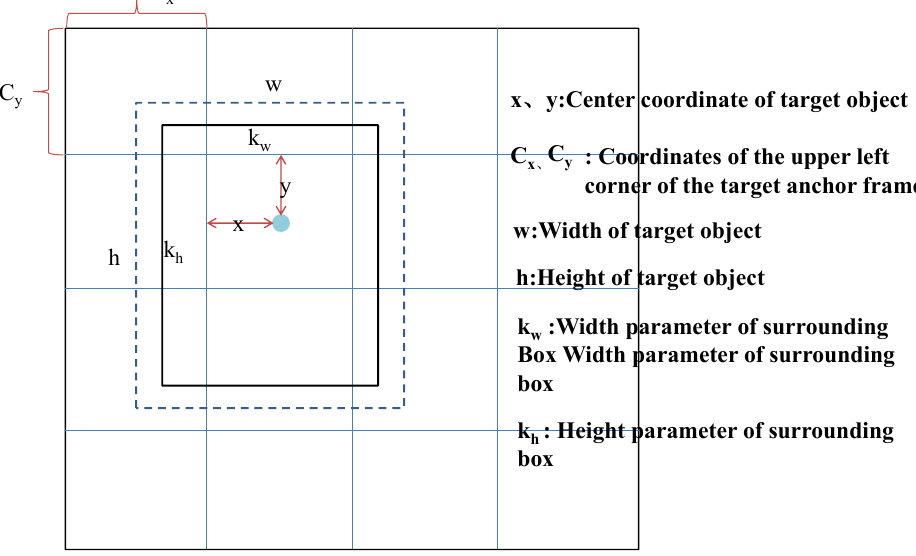
Figure 1. The object position.